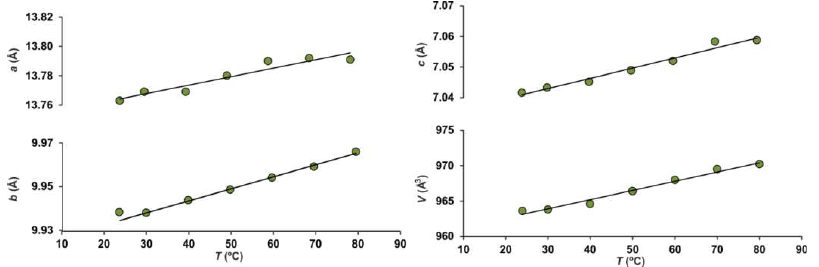
Figure 4. The dependencies of the unit-cell parameters versus temperature for NH 4 MgCl 3 ·6H 2 O phase.